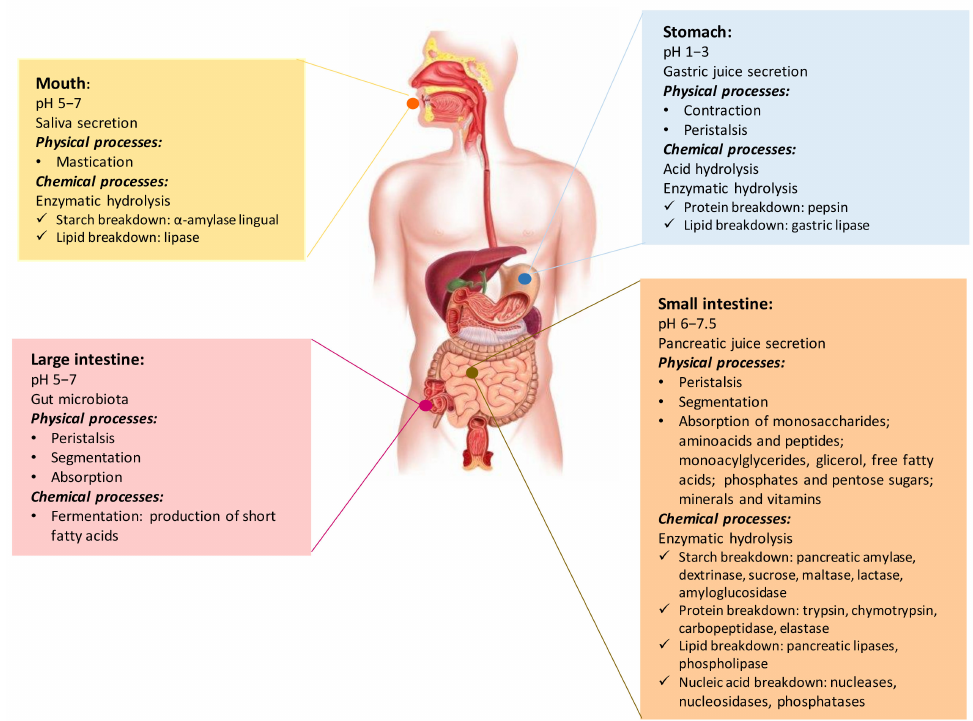
Figure 1. Physical and chemical processes occurring in the human digestive